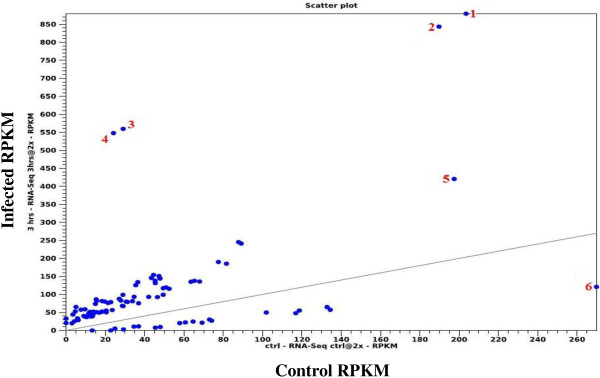
Scatter plot of control RNA-seq RPKM versus infected RNA-seq RPKM of significant transcripts (p < 0.05) with absolute fold change value of 2 or more. Most genes from both samples are closely clustered except for 4 genes label 1 to 6. 1 and 2 are MX1 transcripts 1 and 2, respectively, 3 and 4 = RSAD2 transcripts 1 and 2, respectively, 5 = PLIN2 and 6 = SERPINB1.